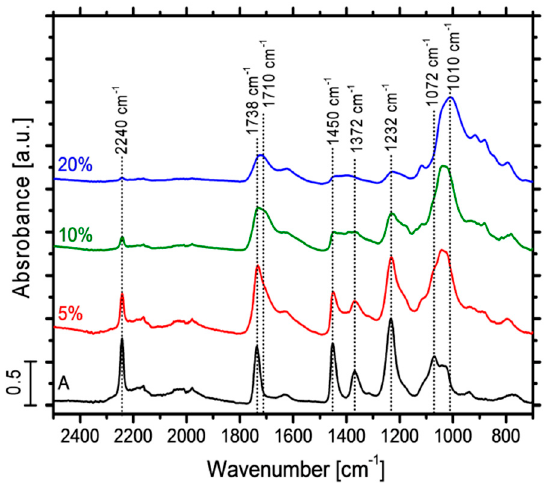
Figure 4. ATR spectra of untreated (A) and CH/MMT-treated acrylic fabrics with 5, 10 and 20% add-ons.